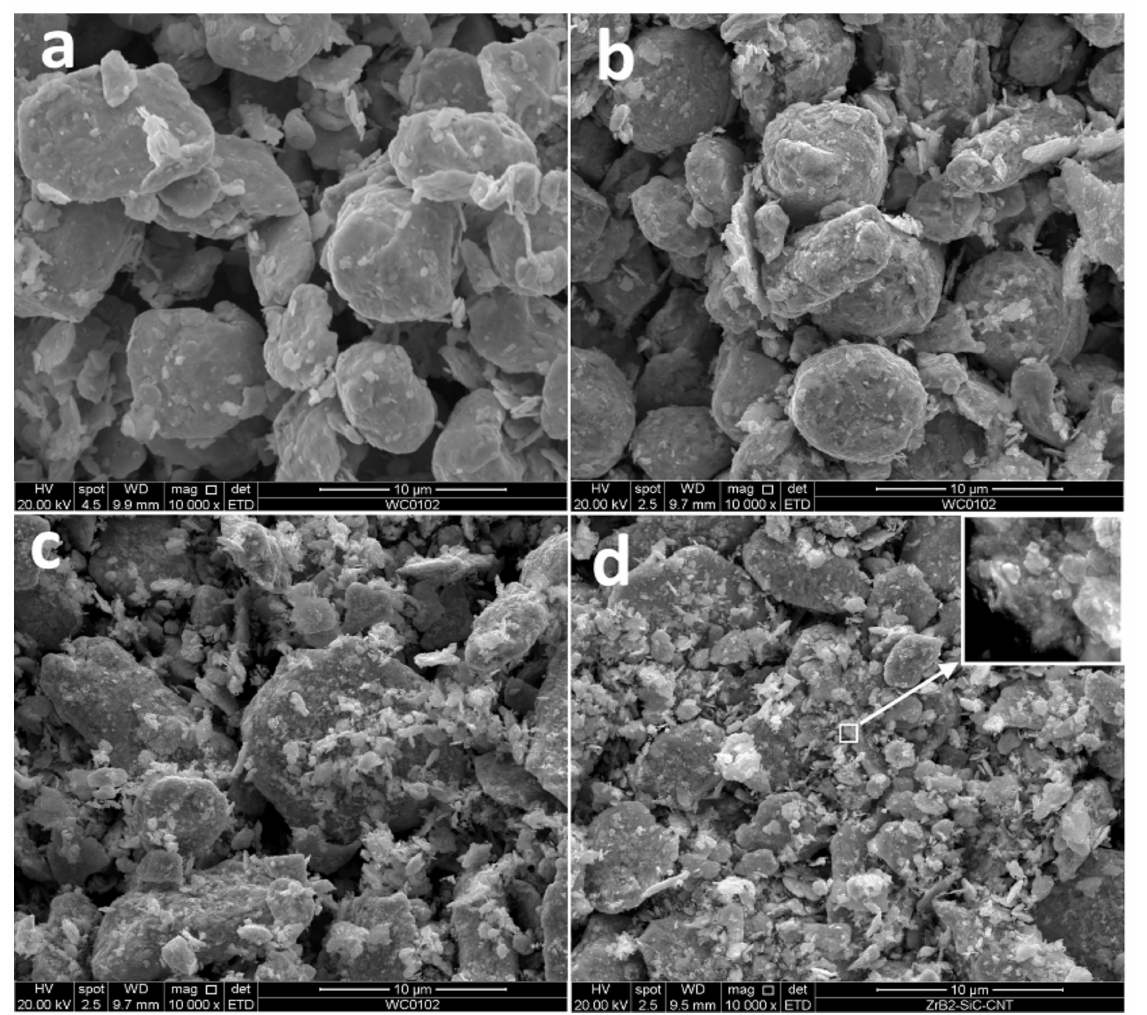
Figure 3. Secondary electron images of milled powders: ( a ) pure tungsten, ( b ) W + 0.6% C, ( c ) W + 1.3% C, ( d ) W + 1.9%